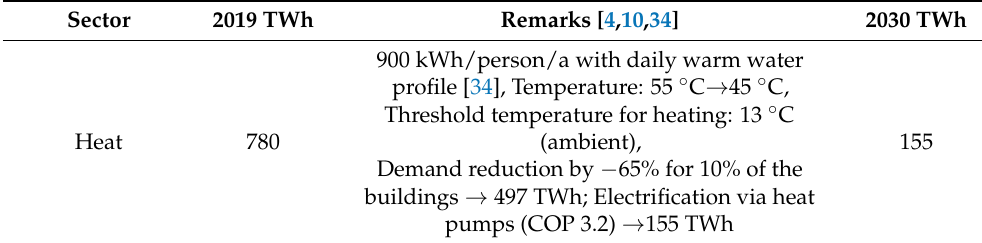
Table A2. Energy consumptions for all sectors in an all-electric system in Germany 2030 before and after thermal insulation and